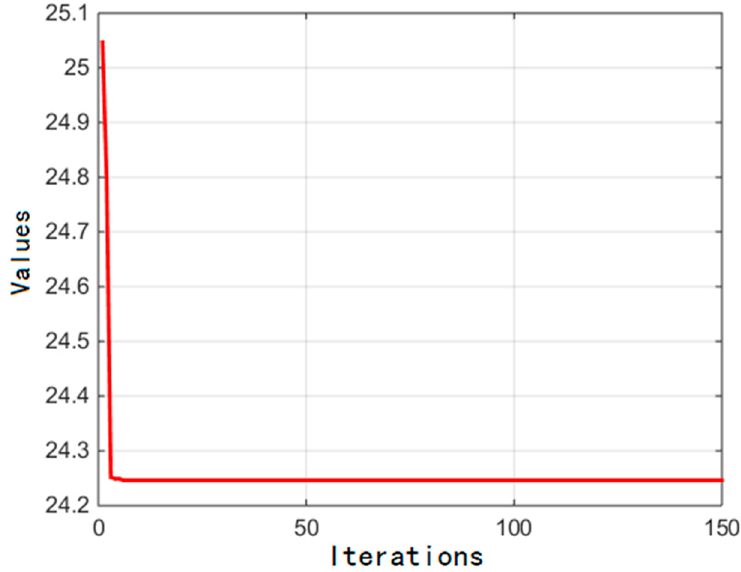
Figure 7. The value change of the objective function.